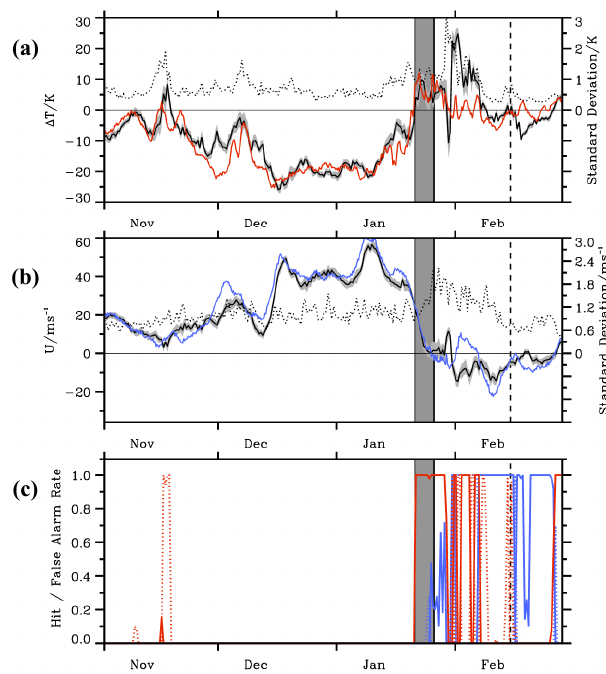
Fig. 13. Major warming criteria for a forecast lead time of 120h. (a) Meridional difference 1T of the zonally averaged temperature Figure 13: Major warming criteria for a forecast lead time of 120 h. (a): meridional difference Δ T of 2 between 85 and 60 ◦ N at 10hPa. (b) Zonally averaged zonal wind the zonally averaged temperature between 85°N and 60°N at 10 hPa. (b): zonally averaged zonal wind 3 U at 60 ◦ N and 10hPa. Red and blue lines in (a) and (b) denote U at 60°N and 10 hPa. Red and blue lines in (a) and (b) denote the verifying analyses, respectively. 4 the verifying analyses, respectively. The gray shaded area encloses The gray shaded area encloses the minimum and maximum values of all EPS members, the solid black 5 the minimum and maximum values of all EPS members, the solid line mark the ensemble mean, and the dotted lines the respective standard deviations σ Δ T and σ U 6 black line mark the ensemble mean, and the dotted lines the respec- defined among the ensemble members around the corresponding ensemble means. (c): Hit rates (solid 7 tive standard deviations σ 1T and σ U defined among the ensemble lines) and false alarm rates (dotted lines) assigned to the forecasted days of the EPS members 8 members around the corresponding ensemble means. (c) Hit rates satisfying the SSW criteria for U (blue) and Δ T (red), respectively. 9 (solid lines) and false alarm rates (dotted lines) assigned to the fore- casted days of the EPS members satisfying the SSW criteria for U (blue) and 1T (red),